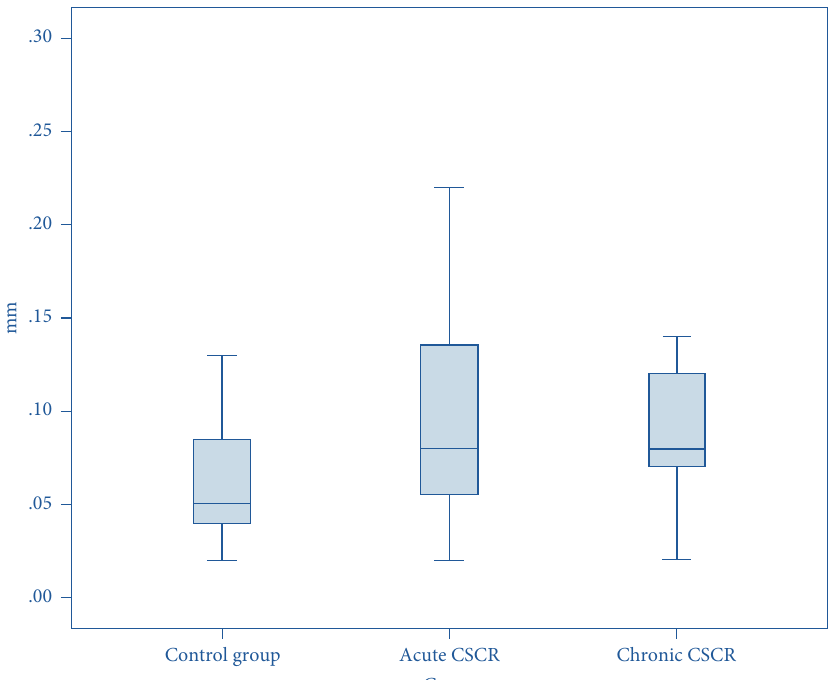
Figure 2: Boxplot of the difference between the two sides in terms of IMT (mm) in participants with acute and chronic CSCR and control group. Table 4: Association between the differences of IMT between the two sides with CSCR disease compared with the control group regarding its chronicity.